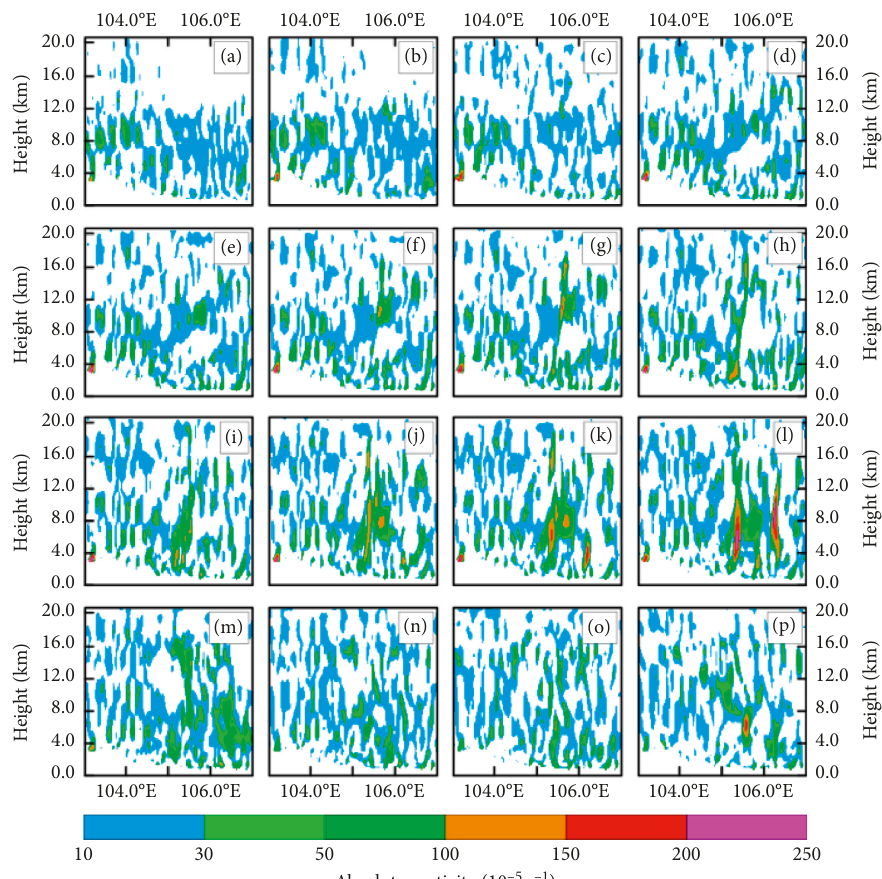
Figure 6: Vertical distribution of absolute vorticity at 32.1 ° N on June 27: (a) 07:00; (b) 09:00; (c) 11:00; (d) 13:00; (e) 13:10; (f) 13:20; (g) 13:30; (h) 14:00; (i) 14:30; (j) 15:00; (k) 15:10; (l) 15:30; (m) 16:30; (n) 17:30; (o) 19:10; (p)